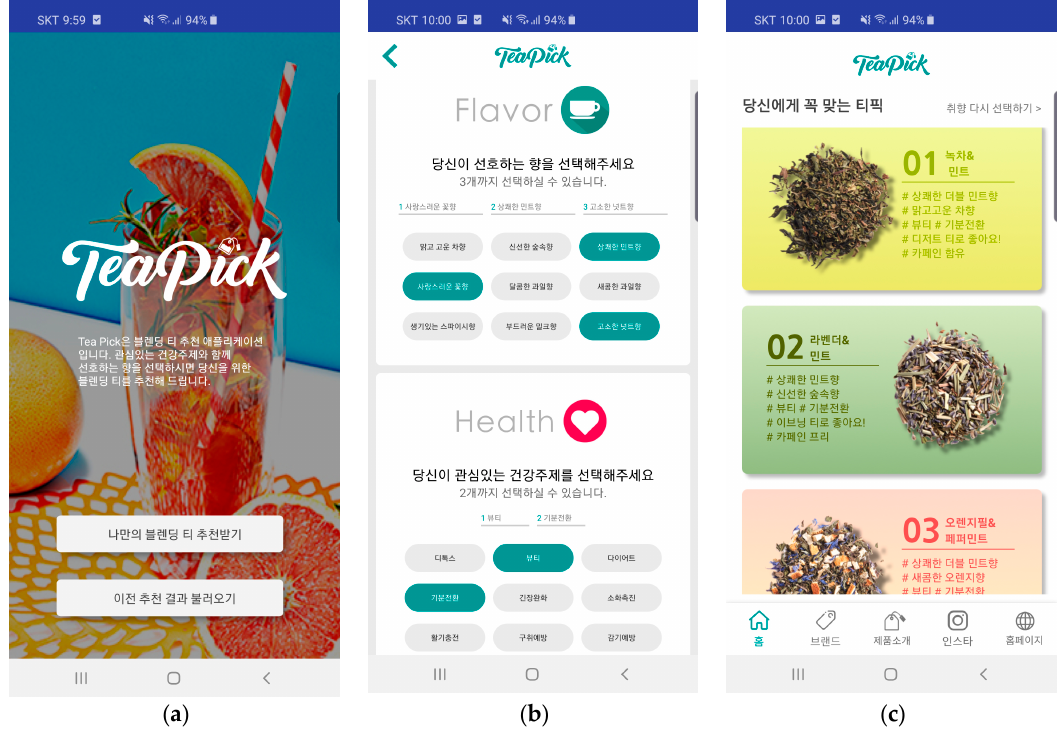
Figure 1. Example screenshots of TeaPick TM prototype application. ( a ) A screen for starting recommendation, ( b ) A screen for user preference input, ( c ) A screen for recommended teas. * * The current prototype is built in Korean for user study.